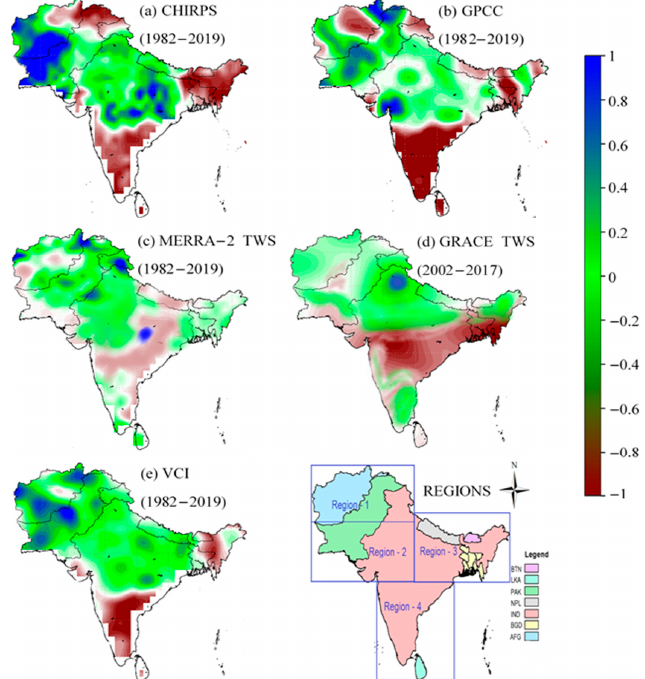
Figure 3. ( a – e ) Spatial patterns of ( a ) SPI from CHIRPS, ( b ) SPI from GPCC, ( c ) TWSI from MERRA-2, (d) SA from GRACE, and ( e ) VCI from AVHRR over South Asia. These patterns have been scaled in the form of ± 1, and hence temporal assessment indicates the genuine magnitude (Figure 5) of SI/SA, where spatial patterns have values nearby ± 1. Remote Sens. 2021 , 13 , x FOR PEER REVIEW